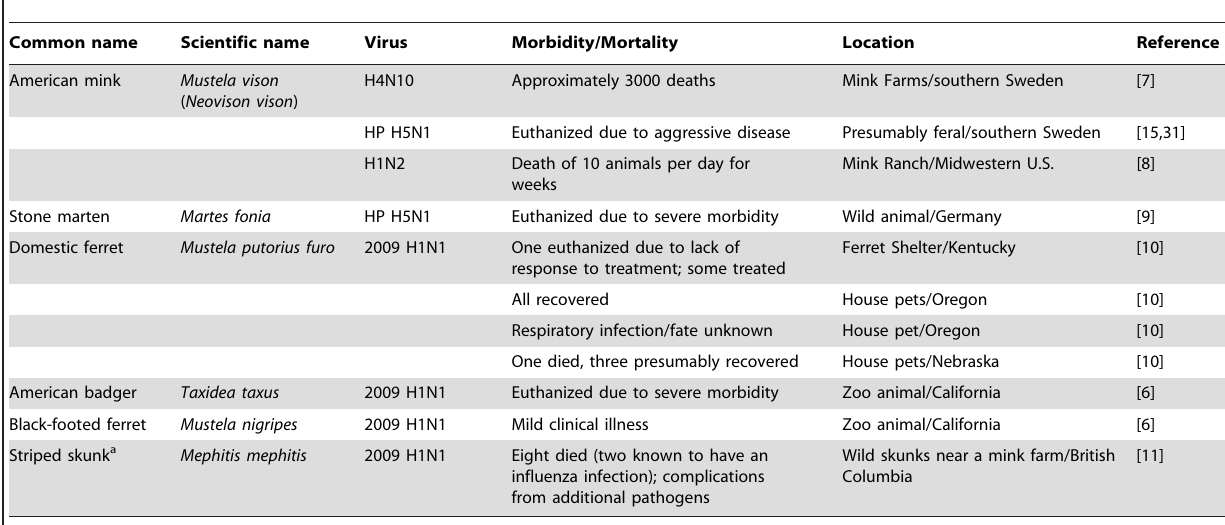
Table 1. Reported natural influenza A virus exposures detected in the mammalian families Mustelidae and